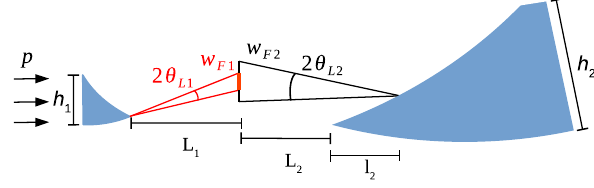
Fig. 3 The extended trajectory of the particles must cross the focal window w F 2 (vertical black line) for these to be trapped in the second crystal. To maximize this probability, the focal window w F 1 (thick red line), analogously defined for the first crystal, must be embedded within w F